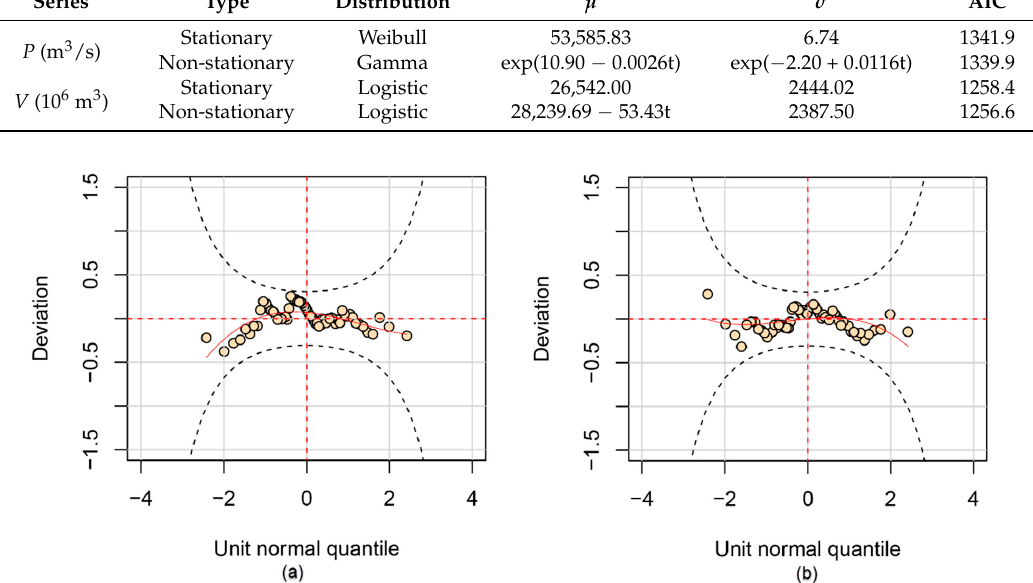
Figure 3. Worm plots for the time varying marginal distribution of ( a ) the flood peak series and ( b ) the flood volume series.